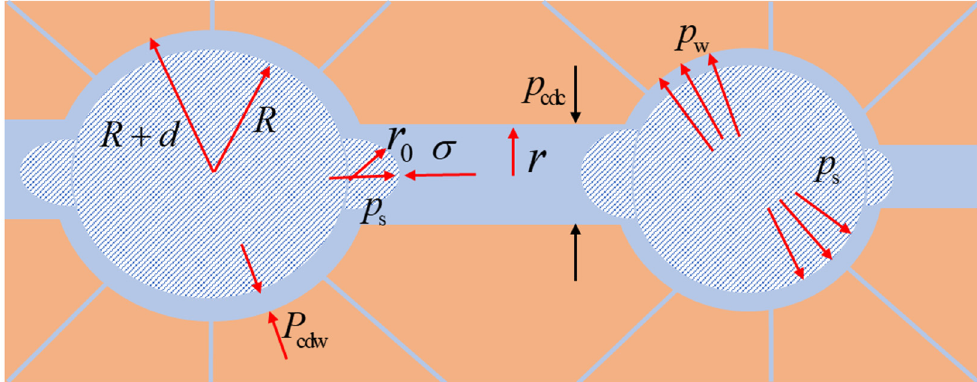
Figure 3. Schematic diagram of the pore mechanics equilibrium of frozen clay.